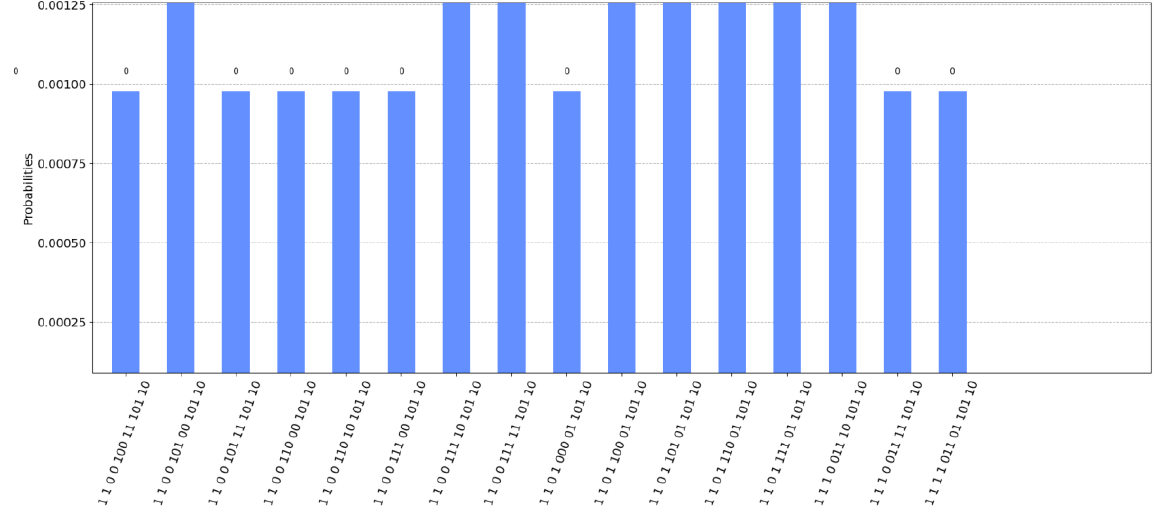
Figure 6. Probability histogram for the exchange circuit (zoomed-in).